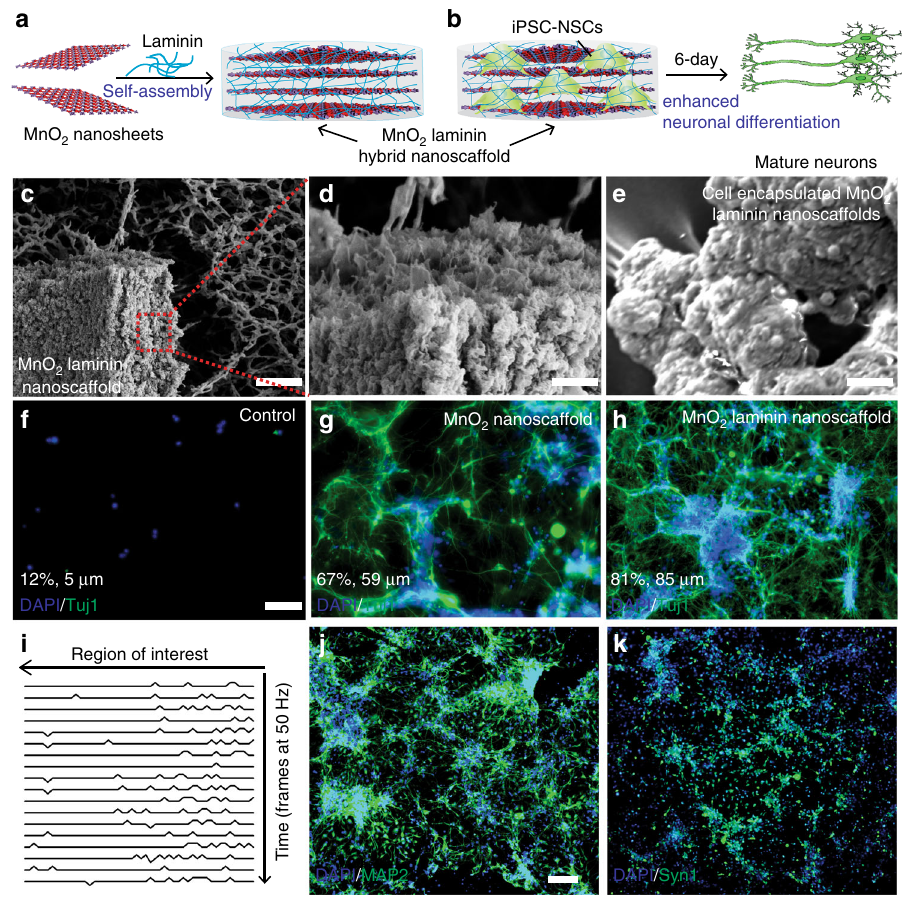
Fig. 4 3D MnO 2 hybrid nanoscaffolds self-assembled with ECM proteins. a , b Schematic diagram illustrating the mechanism for the self-assembly of ECM protein (laminin) and MnO 2 nanosheets through a non-covalent crosslinking mechanism. This mechanism was utilized to synthesize MnO 2 laminin hybrid nanoscaffolds, and iPSC-NSCs cultured on MnO 2 -laminin hybrid nanoscaffolds successfully differentiated into mature (MAP2 + ) neurons after 6 days ( b ). c – e Representative SEM images of MnO 2 laminin hybrid nanoscaffolds ( c , d ), and iPSC-NSC-encapsulated hybrid nanoscaffolds ( e ). f – h Immunostaining results on neuronal markers (TuJ1, labeled with green) demonstrate signi fi cant enhancements of cell adhesion and neuronal differentiation of iPSC-NSCs differentiated on MnO 2 laminin hybrid nanoscaffolds ( h ) compared to both control (glass, f ) substrates and MnO 2 hybrid nanoscaffolds ( g ). Average percentage of neuron and neurite lengths were labeled on the bottom left of each image. i Time-lapse calcium imaging results of iPSC-NSC differentiated neurons on MnO 2 laminin hybrid nanoscaffolds. j , k representative immunostaining images on mature neuronal markers ( i : MAP2 and k : Synapsin 1, labeled with green) from iPSC-NSC-differentiated neurons on MnO 2 laminin hybrid nanoscaffolds. Scale bars: c 10 μ m; d 500 nm; e – h 100 μ m; j , k 100 μ